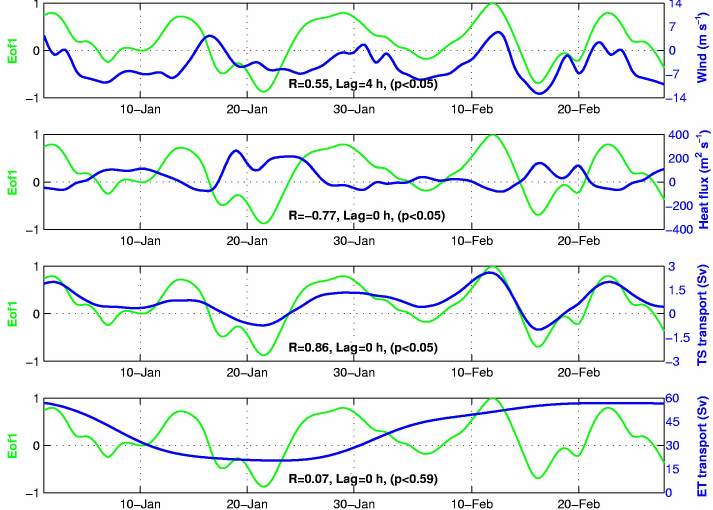
Figure 10. Temporal variation of EOF1, north–south component of wind speed, surface net heat flux, and TSC flux across the TWS section, and Kuroshio flux across the ET section. Their linear correlation coefficients R and time lags are also indicated in each panel. The p value is a declining indicator, which indicates the impact significance of the linear correlation coefficients R , whereby R has statistical significance and the confidence level is larger than 95% when the p value is less than 0.05.